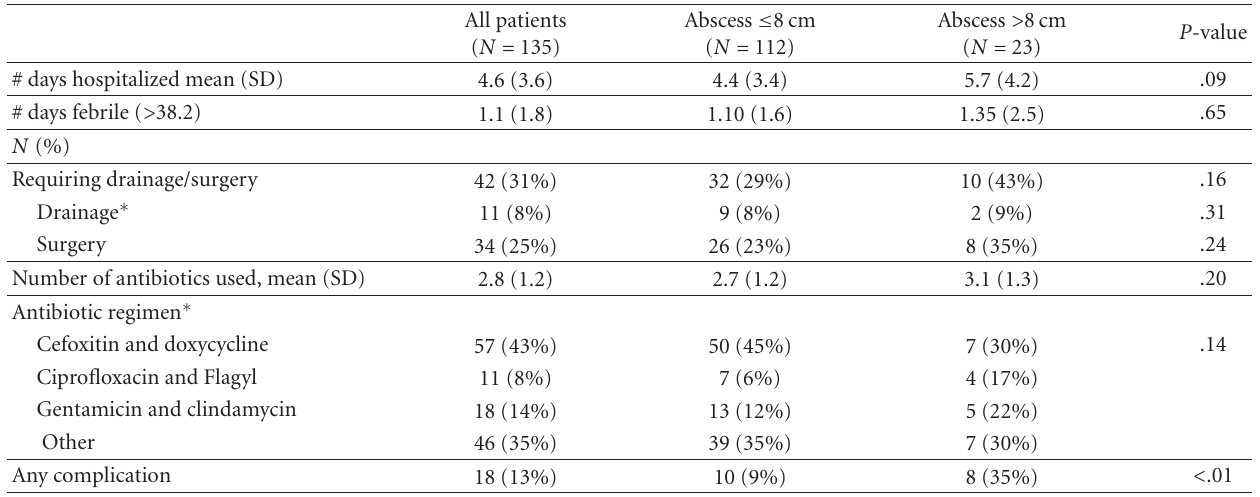
Table 3: Outcomes and initial antibiotic regimen by abscess size.